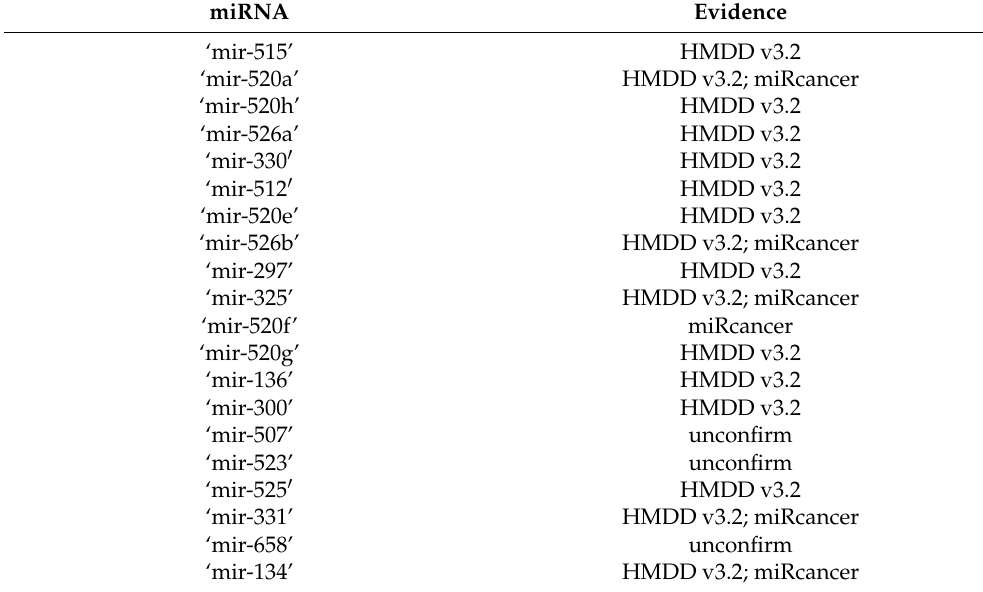
Table 1. TLNPMD was applied to HCC to predict the top 20 disease-related miRNAs.